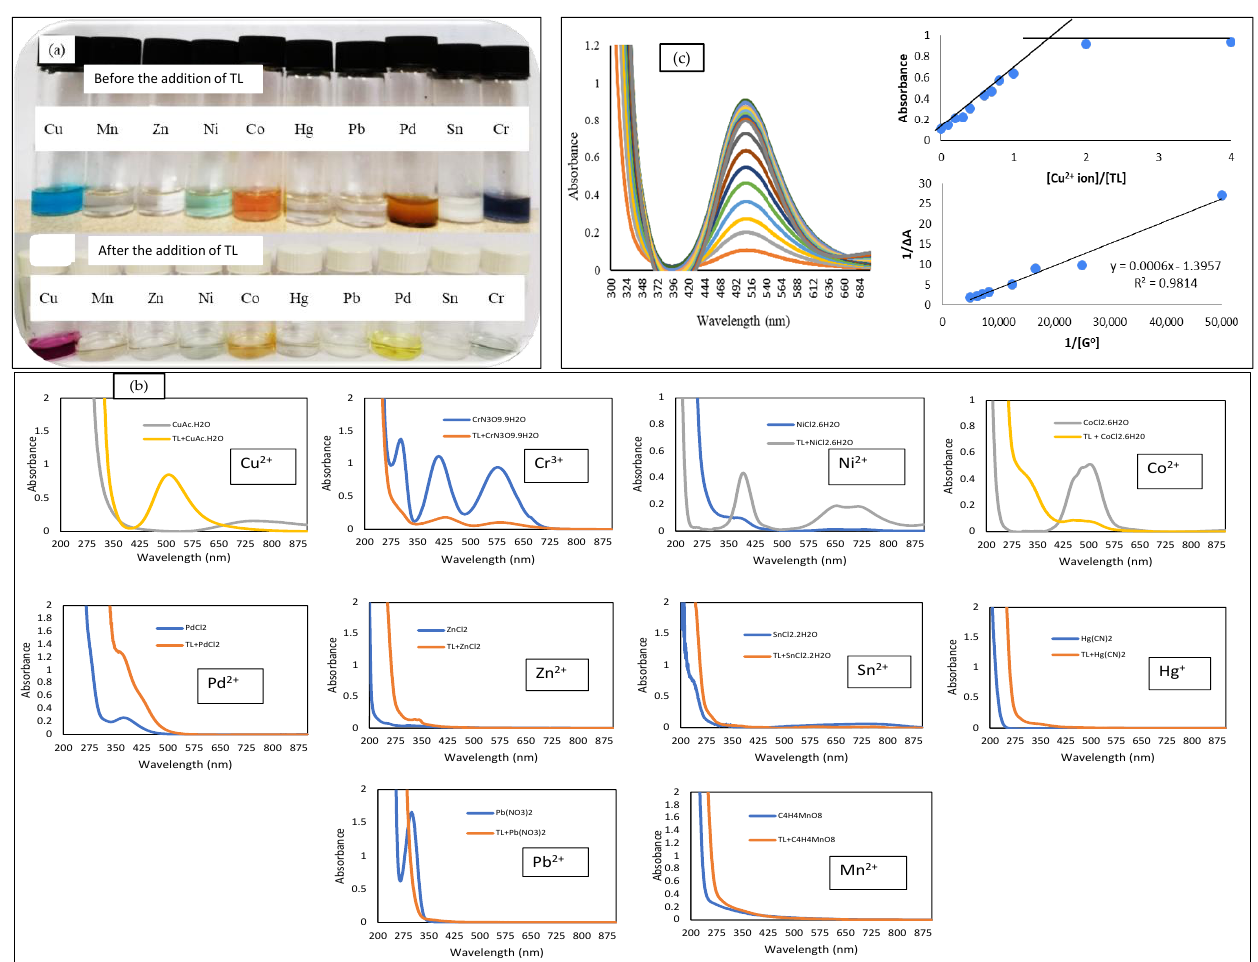
Figure 2. ( a ) Colorimetric sensing of TL compound towards a series of 8 × 10 −2 M metal ions in acetonitrile solvent, before and after the addition of TL compound; ( b ) UV-vis spectrum of TL before and after the addition of metals, and ( c ) UV-vis absorption titration of TL upon gradual increase of 3 µL 8 × 10 −2 M Cu 2+ metal ion solution in (CH 3 CN: H 2 O, 1:1); ( c ) (inset) Molar ratio plot of absorbance against ratio of copper ion with TL, which shows a ratio of 1:1; and ( c ) (inset) Benesi – Hildebrand plot to determine the binding constant.